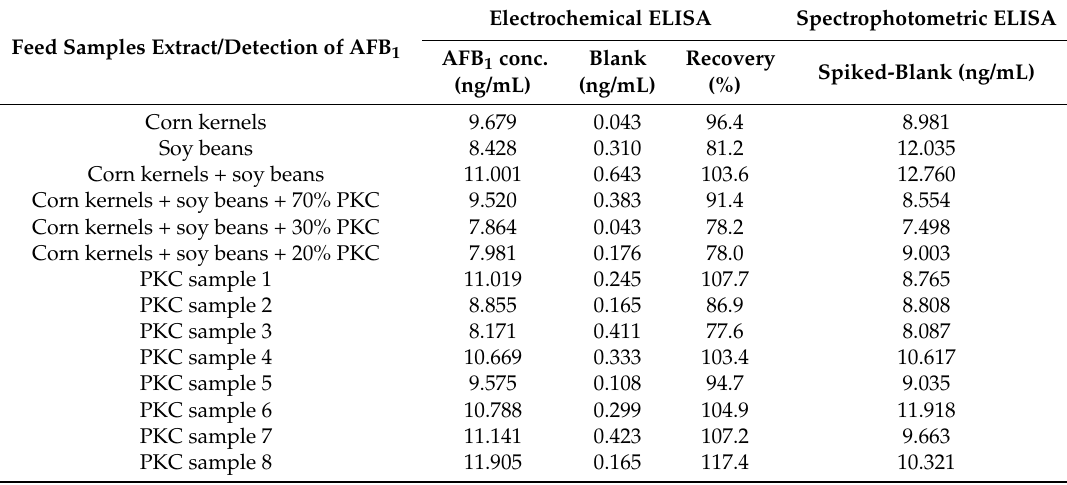
Table 1. Comparison of AFB 1 in spiked feed samples between electrochemical ELISA and spectrophotometric